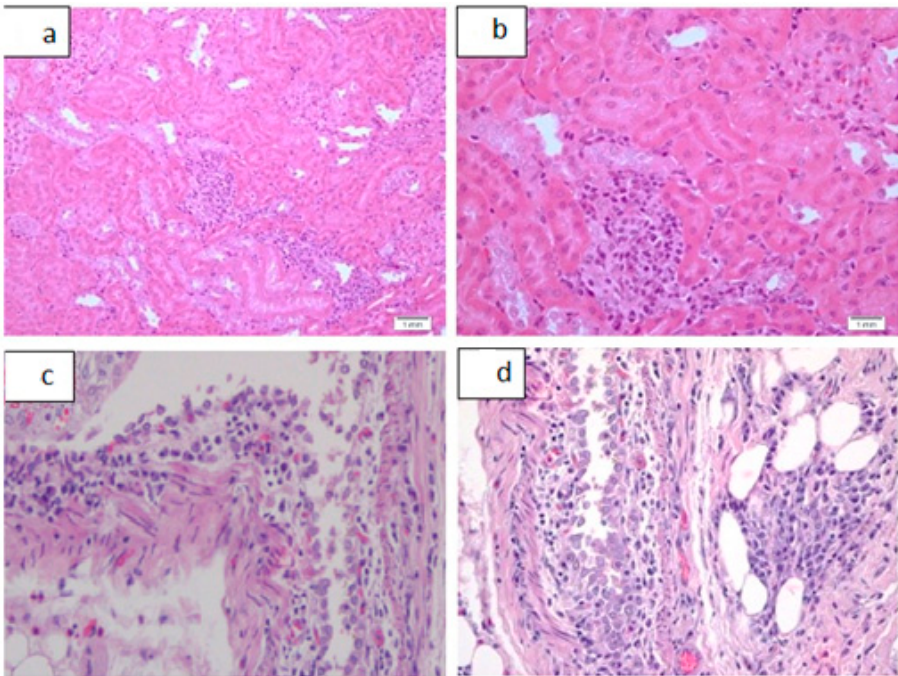
Figure 4. Spectrum of renal inflammatory changes as seen in acute toxicity study. ( a ): Moderate renal interstitial inflammation, H&E, ×20. ( b ): Moderate renal interstitial inflammation, H&E, ×40. ( c ): moderate plasmacytic pyelitis, H&E, ×20. ( d ): moderate plasmacytic pyelitis, H&E, ×40.